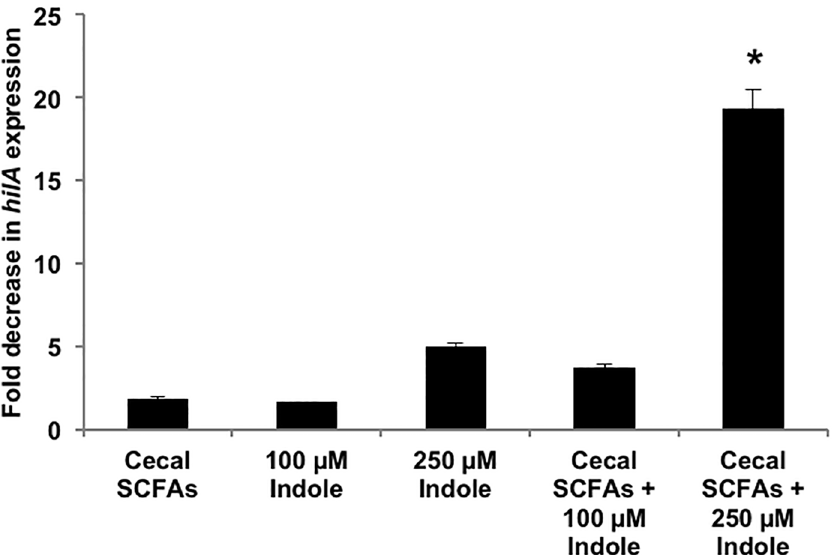
Fig 6. Effect of indole in combination with cecal SCFAs on hilA expression. SPI-1 reporter strain for hilA was treated overnight with and without indole (100 μ M and 250 μ M) in the presence of 200 mM cecal SCFAs or 200 mM NaCl, and the ß-gal activity was measured in exponential phase cultures after dilution. Data shown are the mean fold decrease (n = 3) in expression of hilA with treatment relative to the control: hilA expression in presence of 200 mM NaCl. (cid:3) denotes statistical significance relative to cecal SCFAs alone at p < 0.05 using the Student’s t -test. Error bars represent SD.